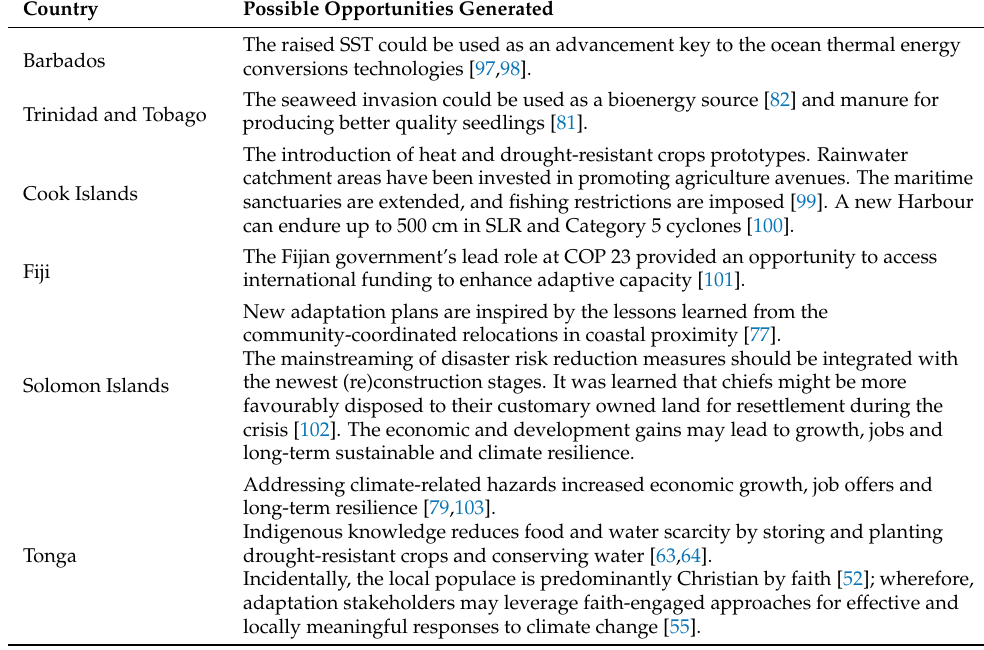
Table 5. Possible opportunities generated by climate